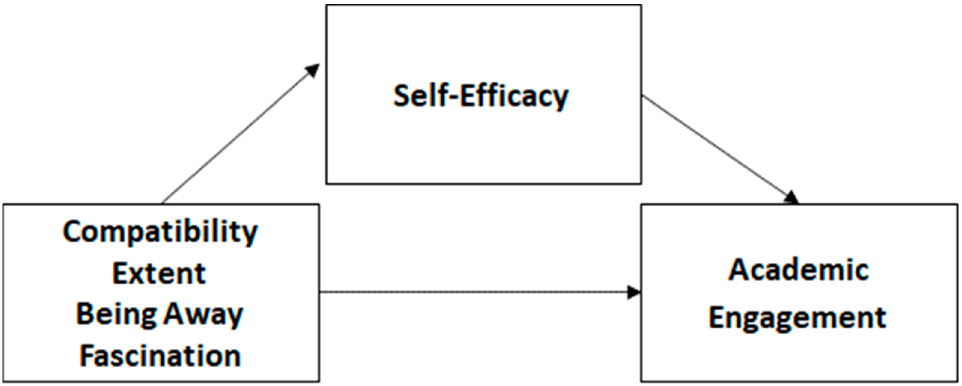
Figure 1. Conceptual